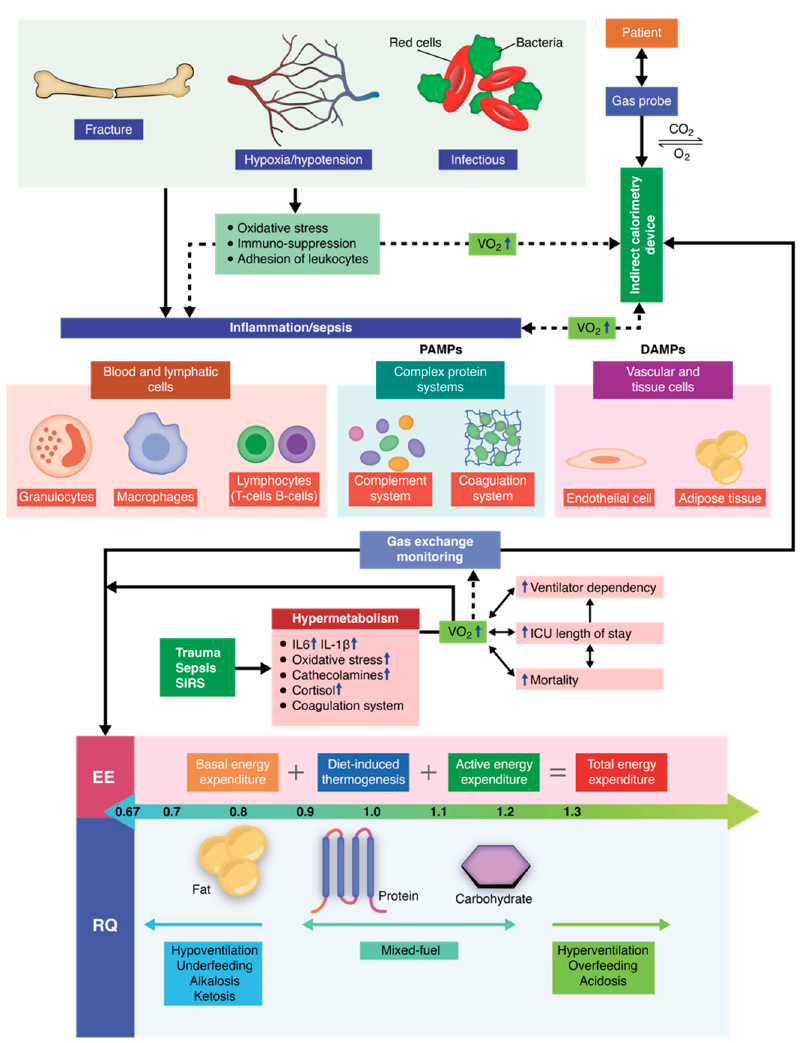
Figure 2. Indirect calorimetry gas exchange monitoring and respiratory quotient interpretation during critically ill conditions.